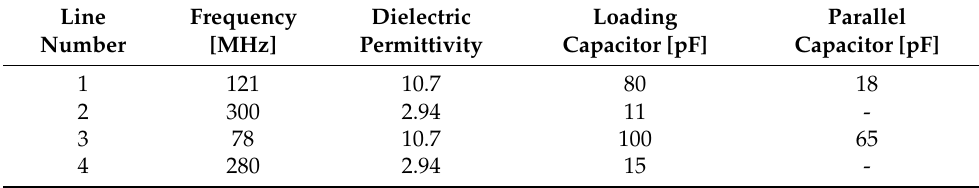
Table 1. The composition of the dielectric materials and capacitors for each conducting